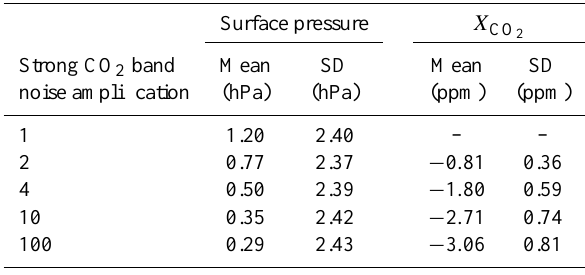
Table 6. Mean and standard deviation of the error in retrieved sur- as functions of the amplification of the face pressure and X CO 2 noise in the strong CO 2 band.